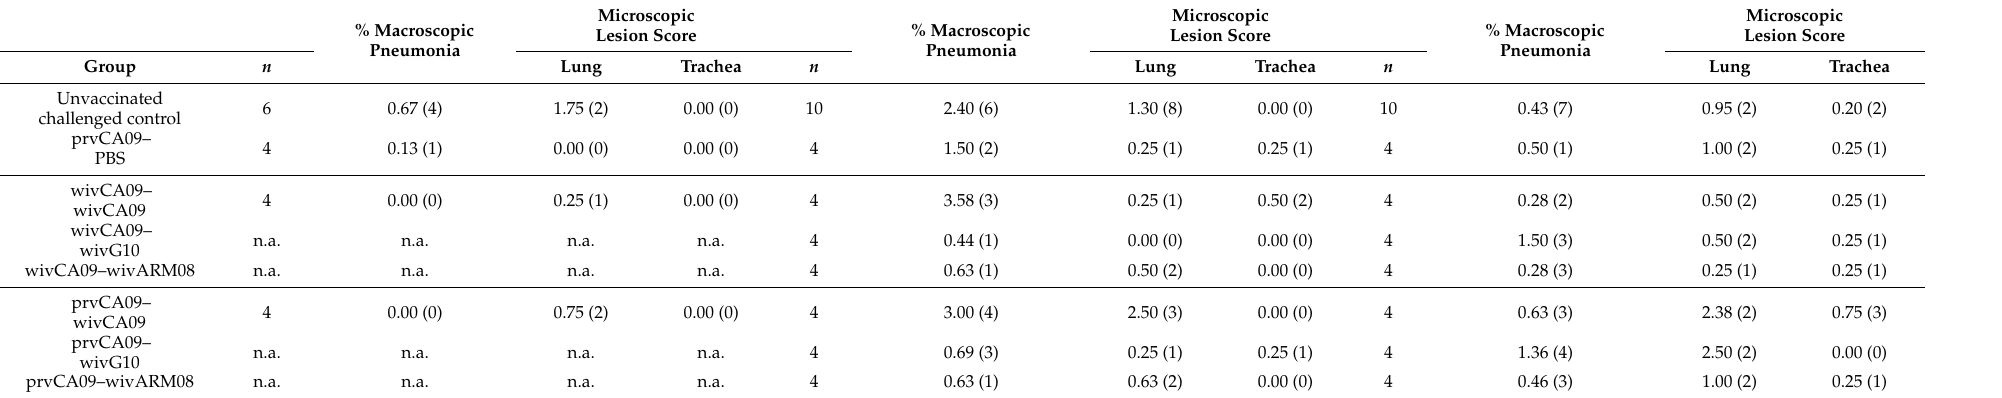
The number between brackets indicates the number of pigs with lesions. n.a.: not applicable; prv(-): Pseudorabies vector vaccine without HA insert; PBS: phosphate buffered saline; wiv: whole inactivated vaccine; prvCA09: Pseudorabies vector vaccine with pH1N1 HA insert. See Figure 1 for full names of swIAVs. Macroscopic pneumonia: the percentage of the surface affected with pneumonia was estimated visually for each lobe, and the total percentage for the entire lung was calculated based on weighted proportions of each lobe to the total volume. Microscopic lung lesion scores are based on the severity of 3 parameters: (1) IPAW: epithelial damage in intrapulmonary airways (0–3), (2) PBLC: peribronchiolar lymphocytic